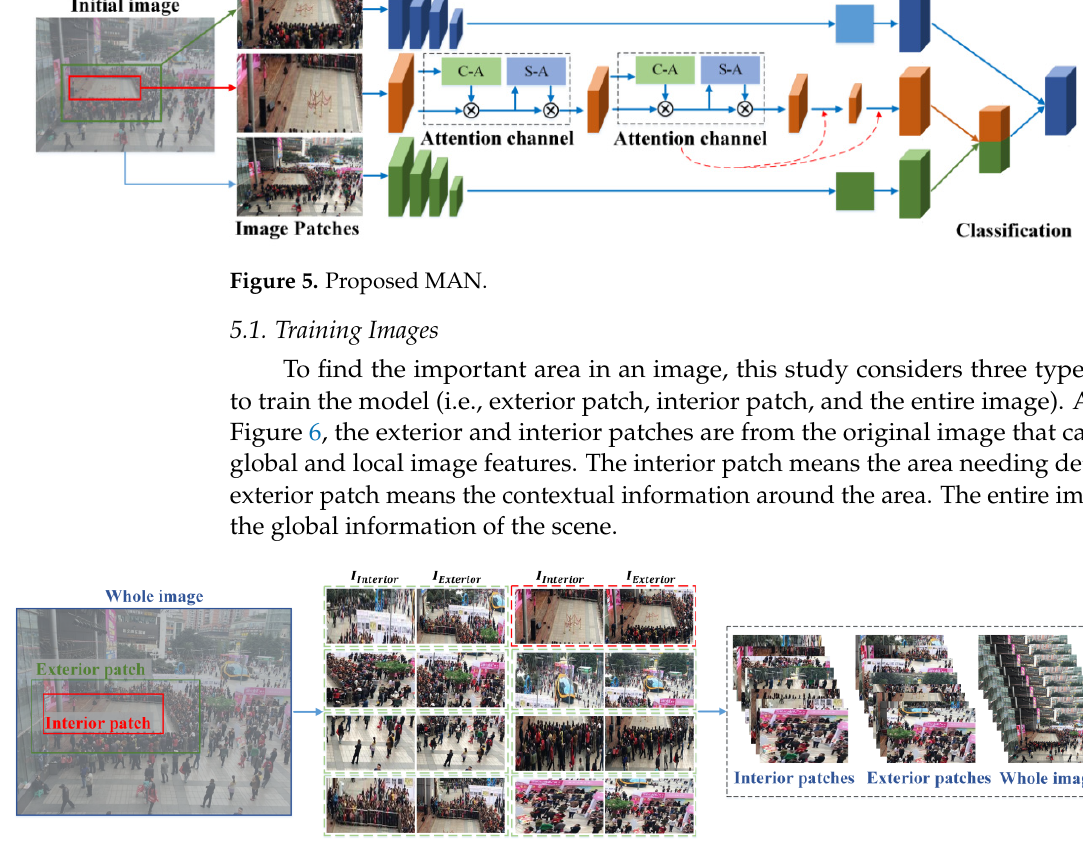
Figure 6. Training image patches of MAN.